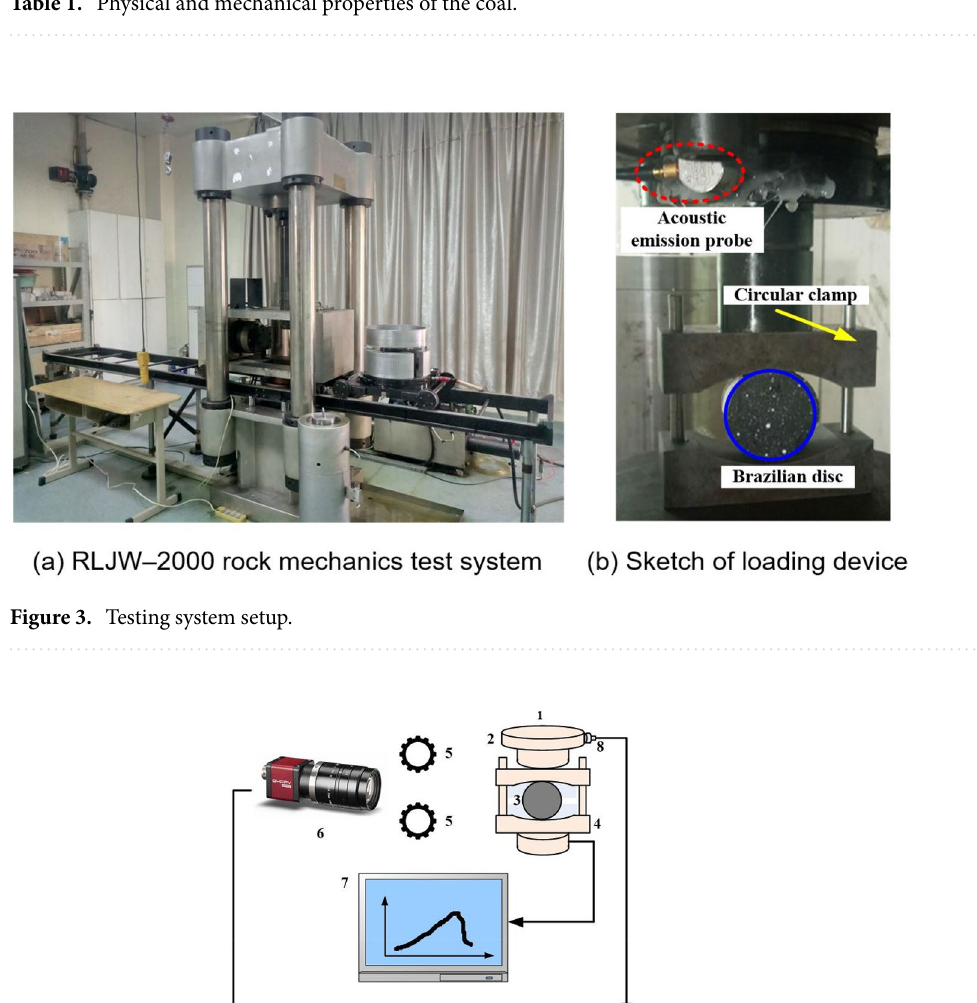
Table 1. Physical and mechanical properties of the coal.